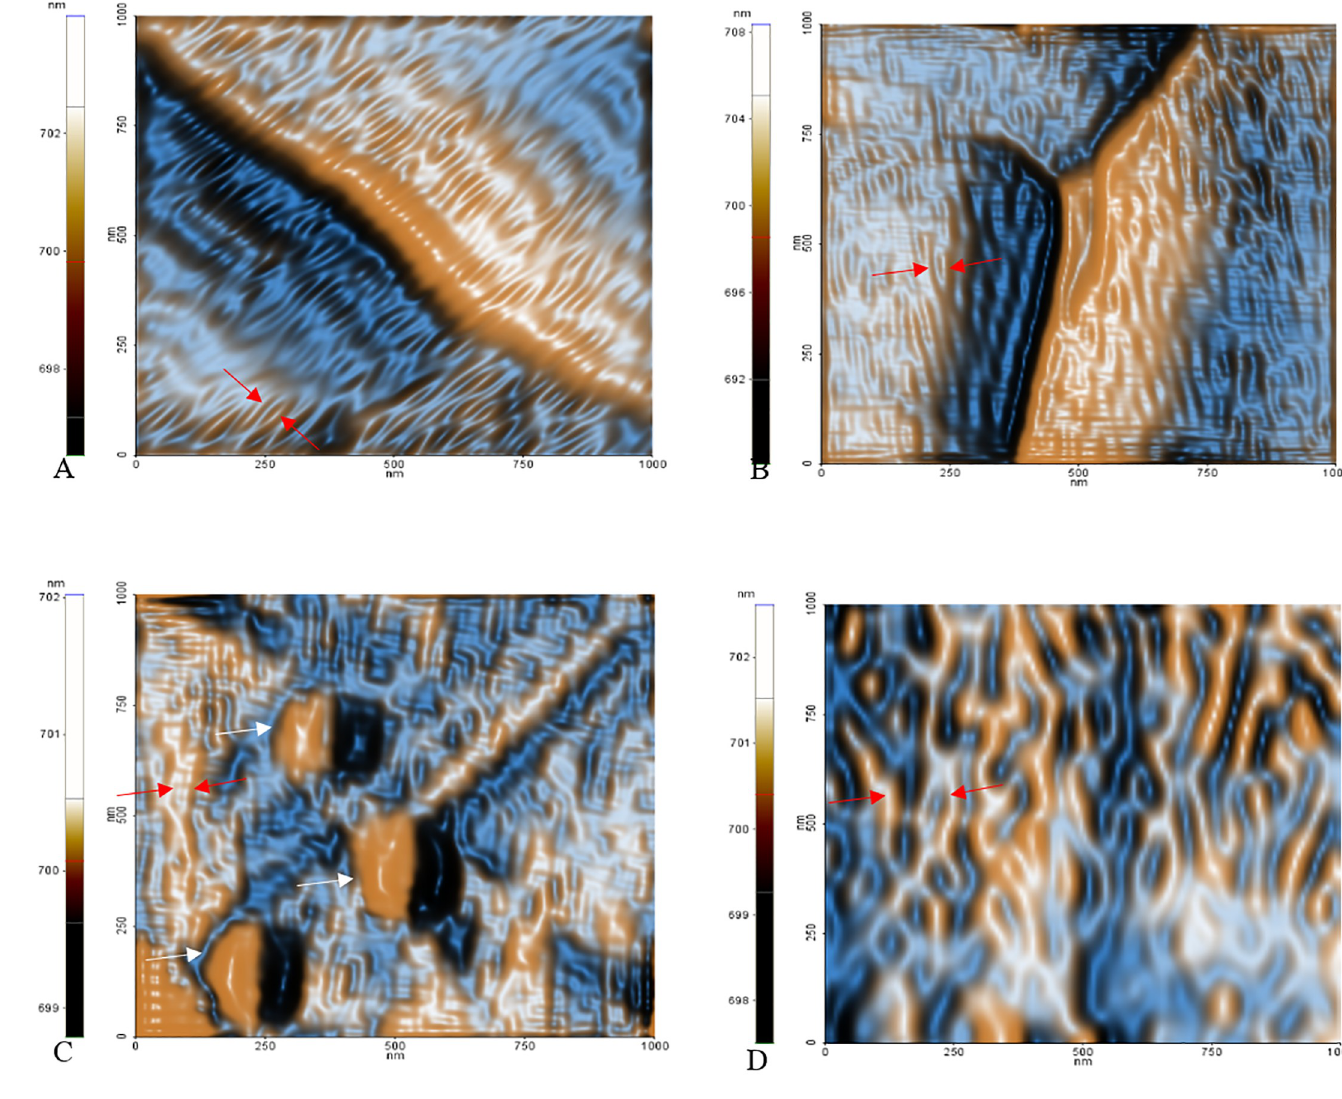
Fig 12. Colour enhanced representative images of FF transformed amplitude signals. Red arrows indicate the nanometric domains of the CaOx crystals free of AE adsorption. Is possible to observe a variation of surface structures dependent on C . officinarum AE increasing concentrations, that probably influence the crystal growth. (A) control sample, (B) 50 μ g, (C) 100 μ g and (D) 1000 μ g dw/ml C . officinarum AE respectively. In (C) white arrows indicate probable AE component(s) adsorption.